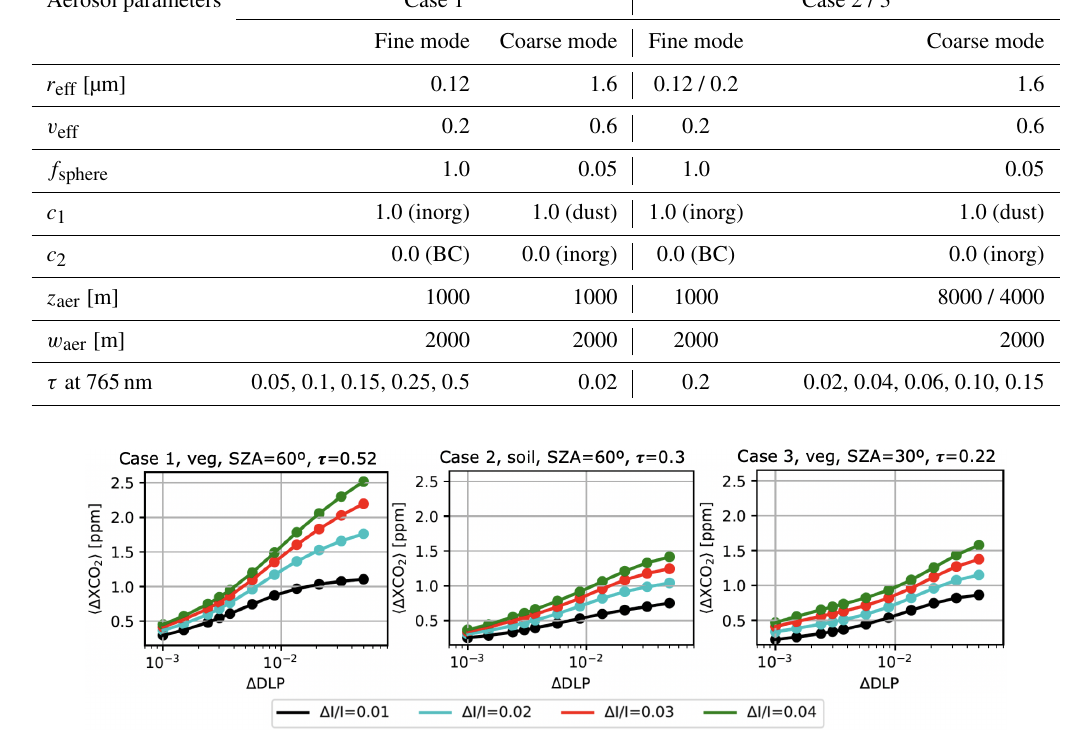
Figure 2. (cid:104) (cid:49) XCO 2 (cid:105) as a function of (cid:49)I/I and (cid:49) DLP, shown for scenarios where the errors are among the largest for each individual case (1, 2, and 3). Here, τ indicates the sum of the fine- and the coarse-mode aerosol optical depth at 765nm.